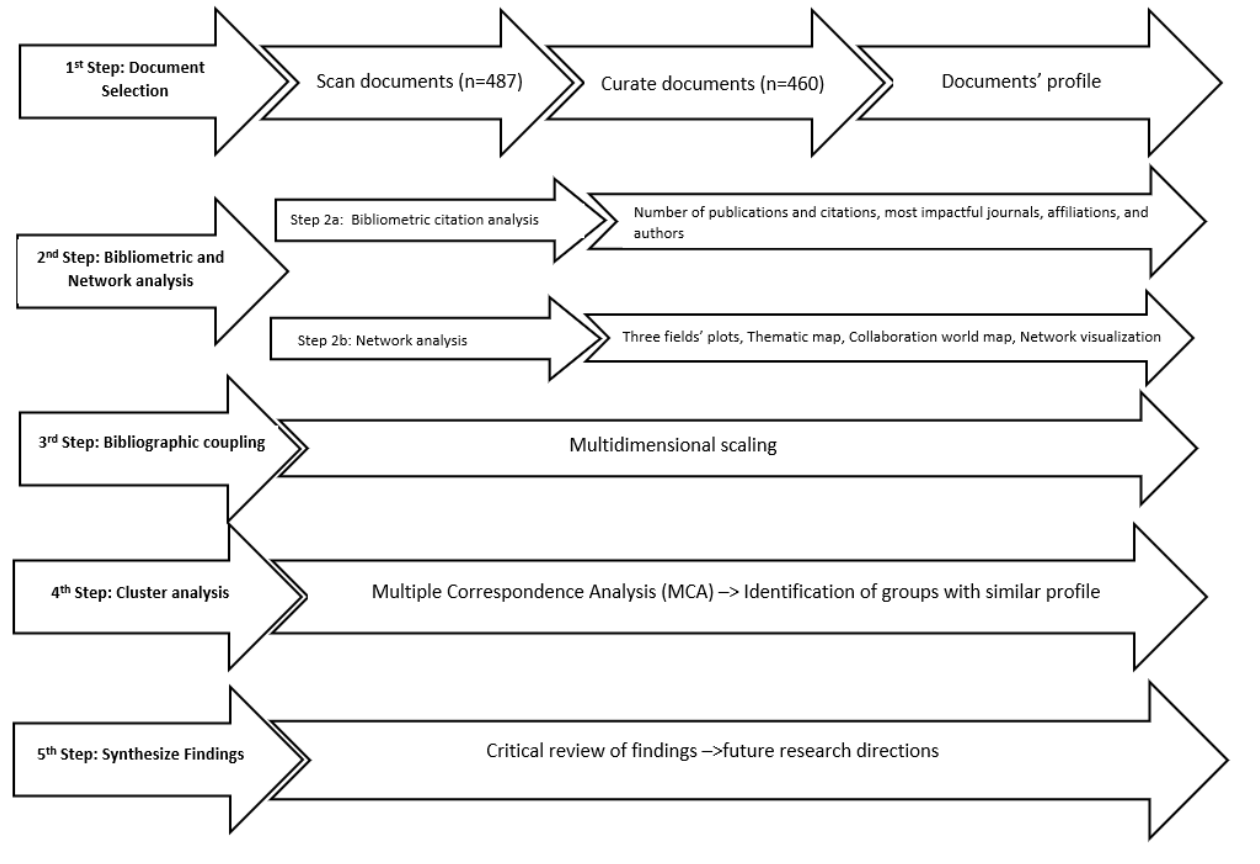
Figure 1. Methodological workflow . Source: Own elaboration.